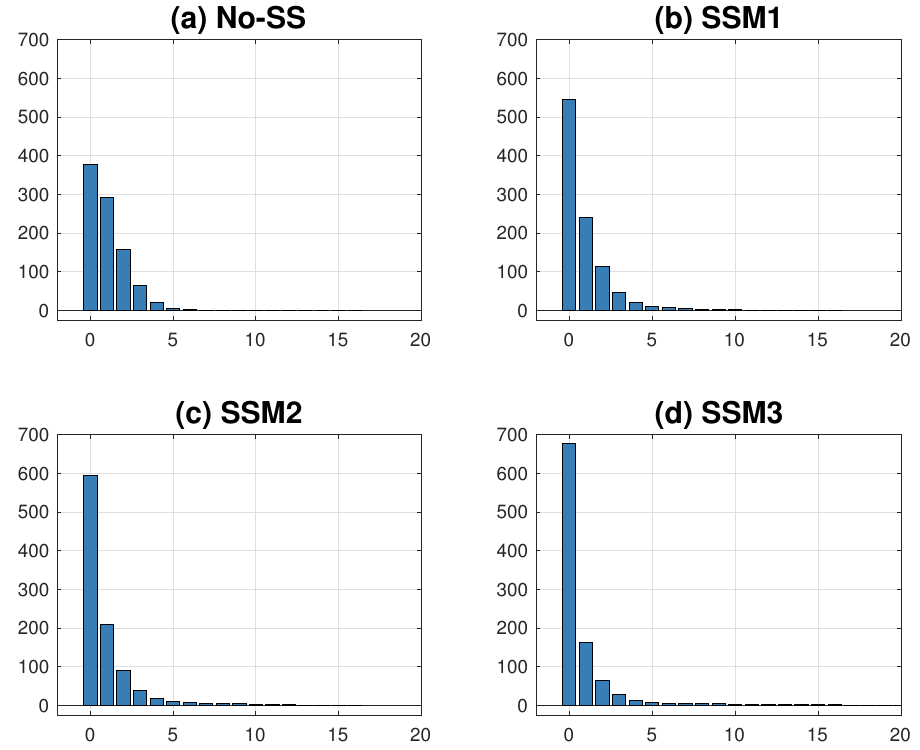
Figure 10. Distributions of secondary cases under four super-spreader models are compared using λ = 10%. SSM3 shows the highest level of heterogeneity while No-SS shows the least heterogeneity.